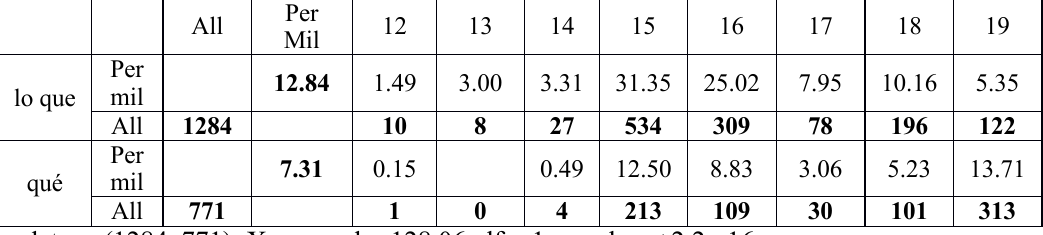
Table 4: ver lo que vs. ver qué